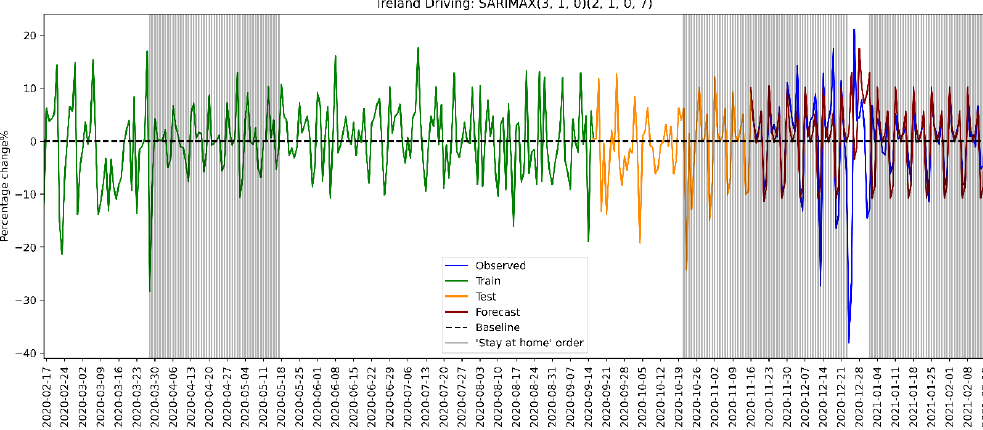
SARIMAX model of driving in relation to “Stay at home” orders in